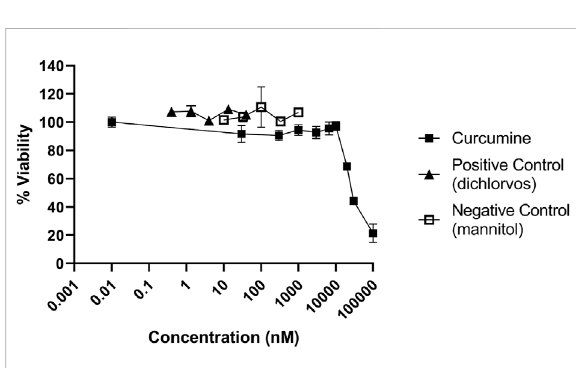
FIGURE 4 Cytotoxicity of control chemicals used in the NRF2 reporter geneassay.U2OScellswereexposedtocurcumin,dichlorvos,and mannitol for 24 h and evaluated using the Alamar blue